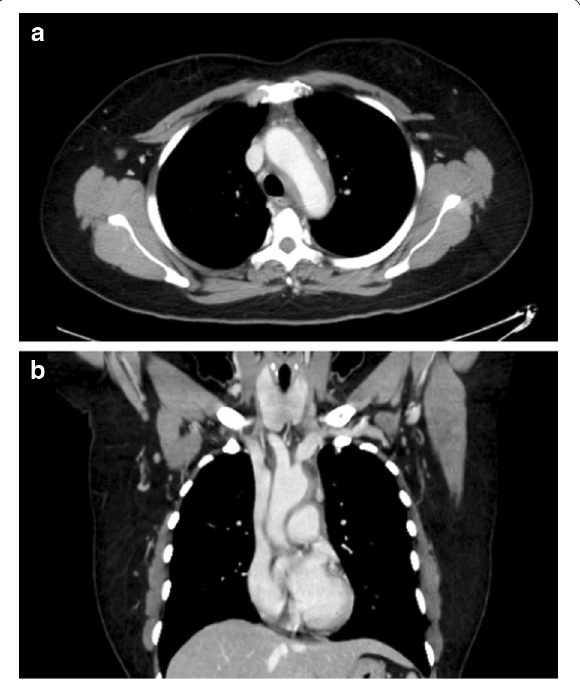
Fig. 1 Computed tomography (CT) scan on admission. CT scan on day 11 reveals diffused wall thickening centering on the aortic arch. Vasculitis was suspected of causing the fever. a Axial plane; b coronal